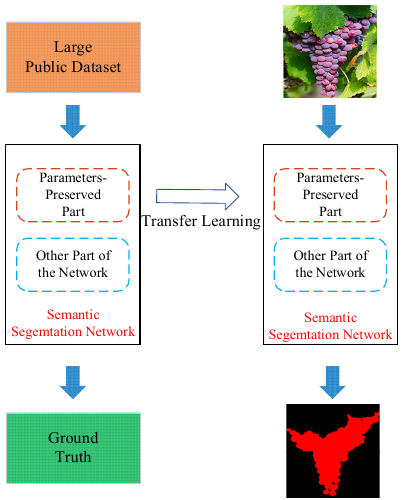
Figure 4. Network training with transfer learning strategy.